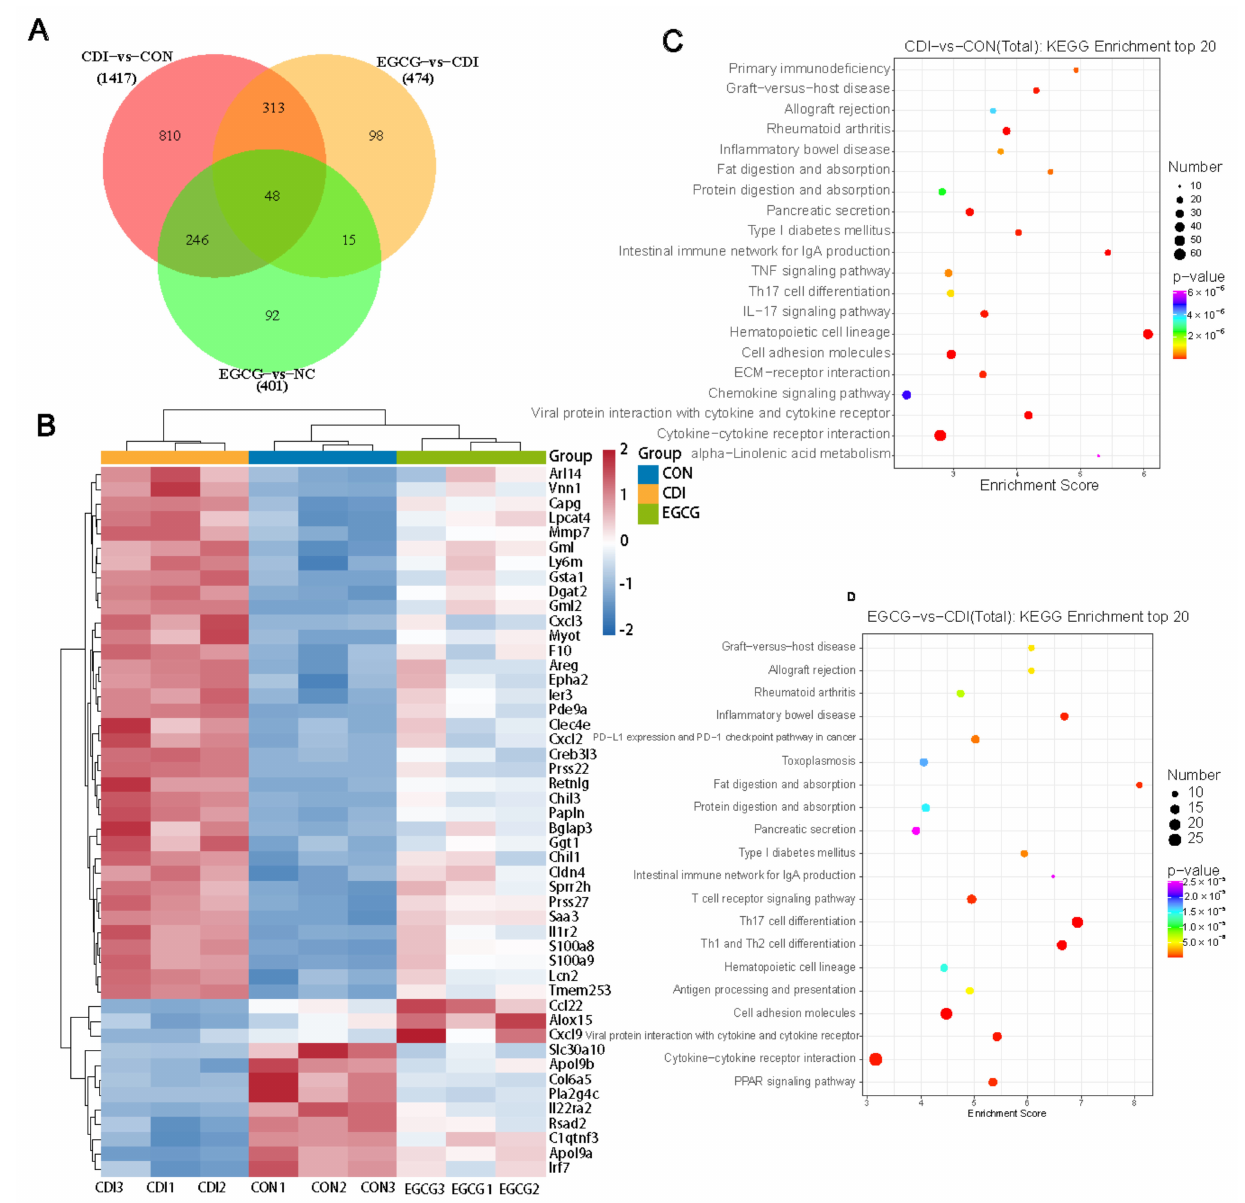
Figure 6. EGCG affects colonic transcriptome alterations. ( A ) Venn diagram showing the differential expression of genes between the CON, CDI, and EGCG groups. ( B ) Heatmap showing the differential expression of genes between the groups. ( C ) KEGG enrichment analysis of the CDI and NC groups. ( D ) KEGG enrichment analysis of the CDI and EGCG